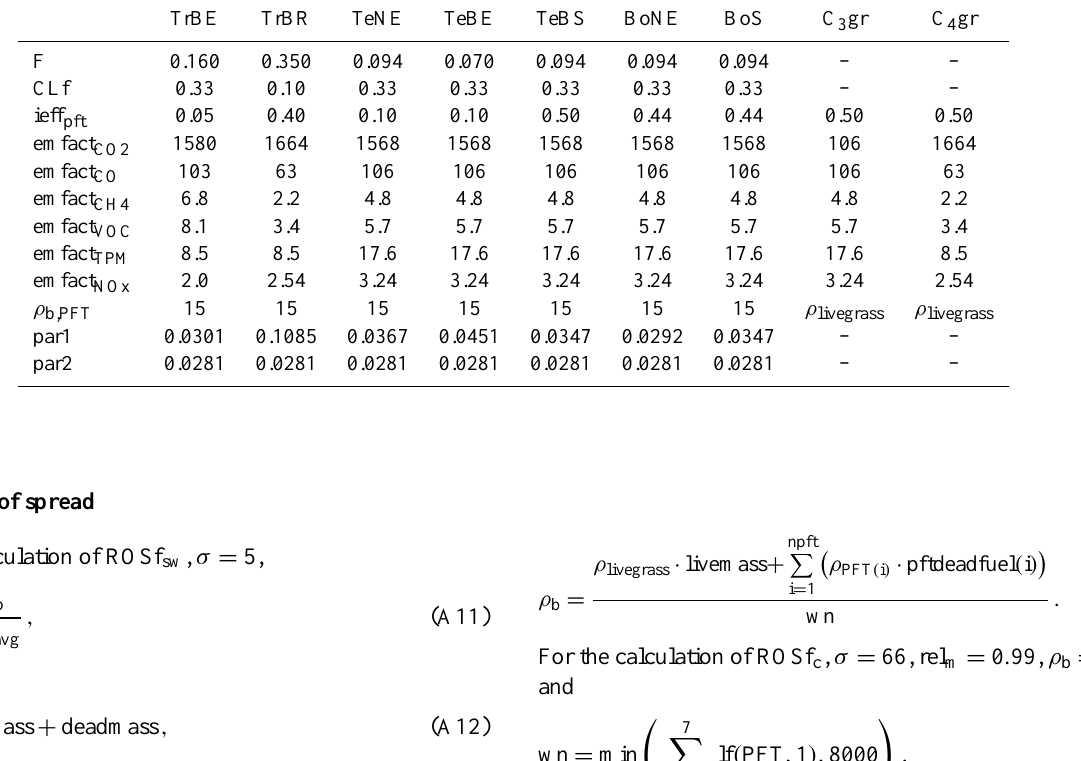
Table A1. PFT-specific parameters. TrBE=tropical broadleaf evergreen, TrBR=tropical broadleaf raingreen, TeNE=temperate needle- leaf evergreen, TeBE=temperate broadleaf evergreen, TeBS=temperate broadleaf summergreen, BoNE=boreal needleleaf